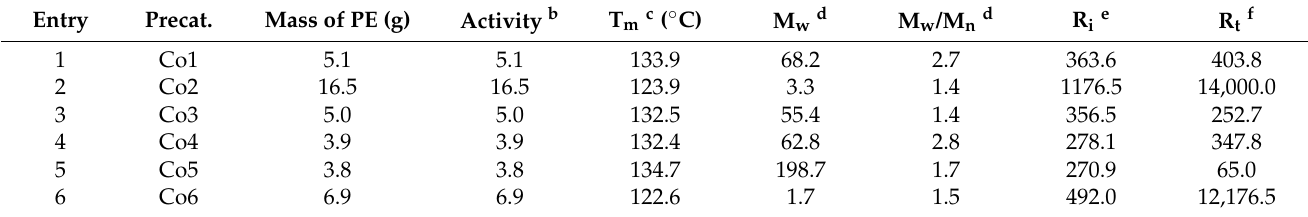
Table 3. Ethylene Polymerization using Co1 – Co6 with MAO as the co-catalyst a